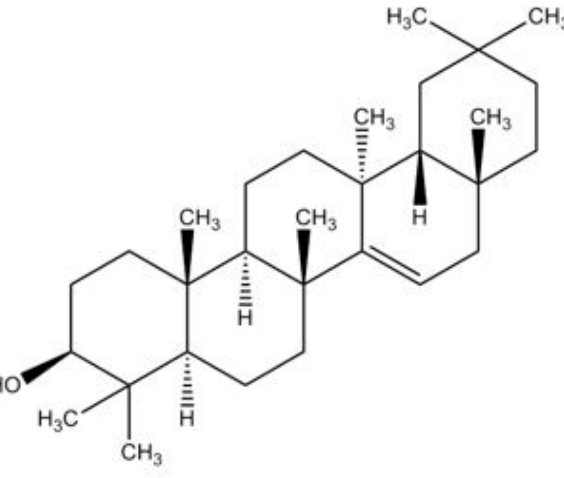
Figure 1. The proposed structure of taraxerol. Adapted from Beaton et al. (1955) [17].